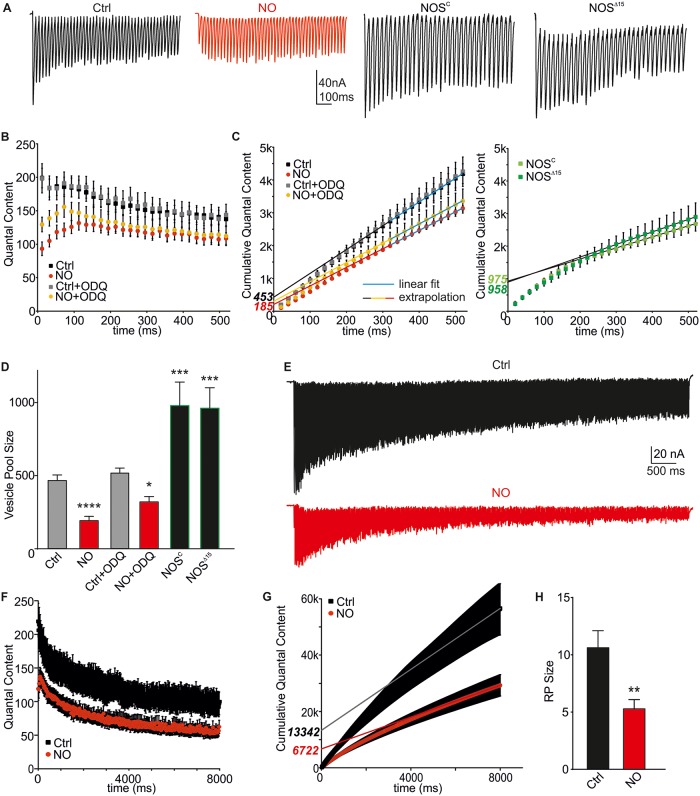
The size of the RRP and RP is reduced by NO and enhanced in NOS “null” NMJs.(A) Raw eEJC recordings of a 50-Hz train, 500 ms. (B) Mean QC for conditions indicated. (C) Cumulative QC with back extrapolated linear regression to the last 200 ms to time 0, yielding an estimated readily releasable vesicle pool size (RRP, intercept with y-axis, pool sizes in italics). (D) Mean RRP sizes for conditions indicated. NO reduces PPR sizes, with ODQ having no effects. NOS “null” NMJs show potentiated responses (ANOVA with post hoc Tukey-Kramer was used for comparisons). (E) Raw eEJC recordings of a 50-Hz train, 8 s. (F) Mean QC for conditions indicated. (G) Cumulative QC with back extrapolated linear regression to the last 2 s to time 0 (w1118 Ctrl and NO), yielding an estimated RP size (intercept with y-axis, pool sizes in italics). (H) Mean RP sizes for conditions indicated. NO reduces RP sizes similarly to RRP sizes. The raw data can be found in S2 Data. Student t test, **p = 0.0062, data denote mean ± SEM in all graphs. Ctrl, control; eEJC, evoked EJC; EJC, excitatory junctional current; NMJ, neuromuscular junction; NO, nitric oxide; NOS, nitric oxide synthase; ODQ, 1H-[1,2,4]oxadiazolo[4,3-a]quinoxalin-1-one; PPR, paired pulse ratio; QC, quantal content; RP, reserve pool; RRP, readily releasable pool.